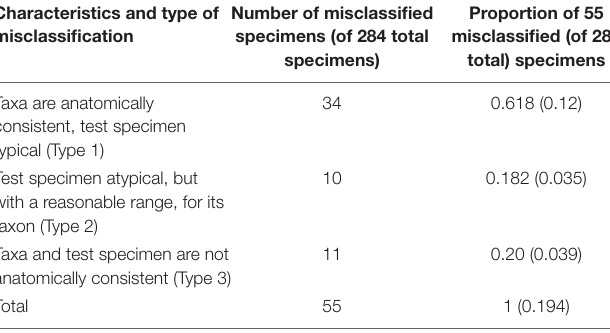
TABLE 4 | Number and proportion of misclassified specimens from Figure 4 by type of misclassification.